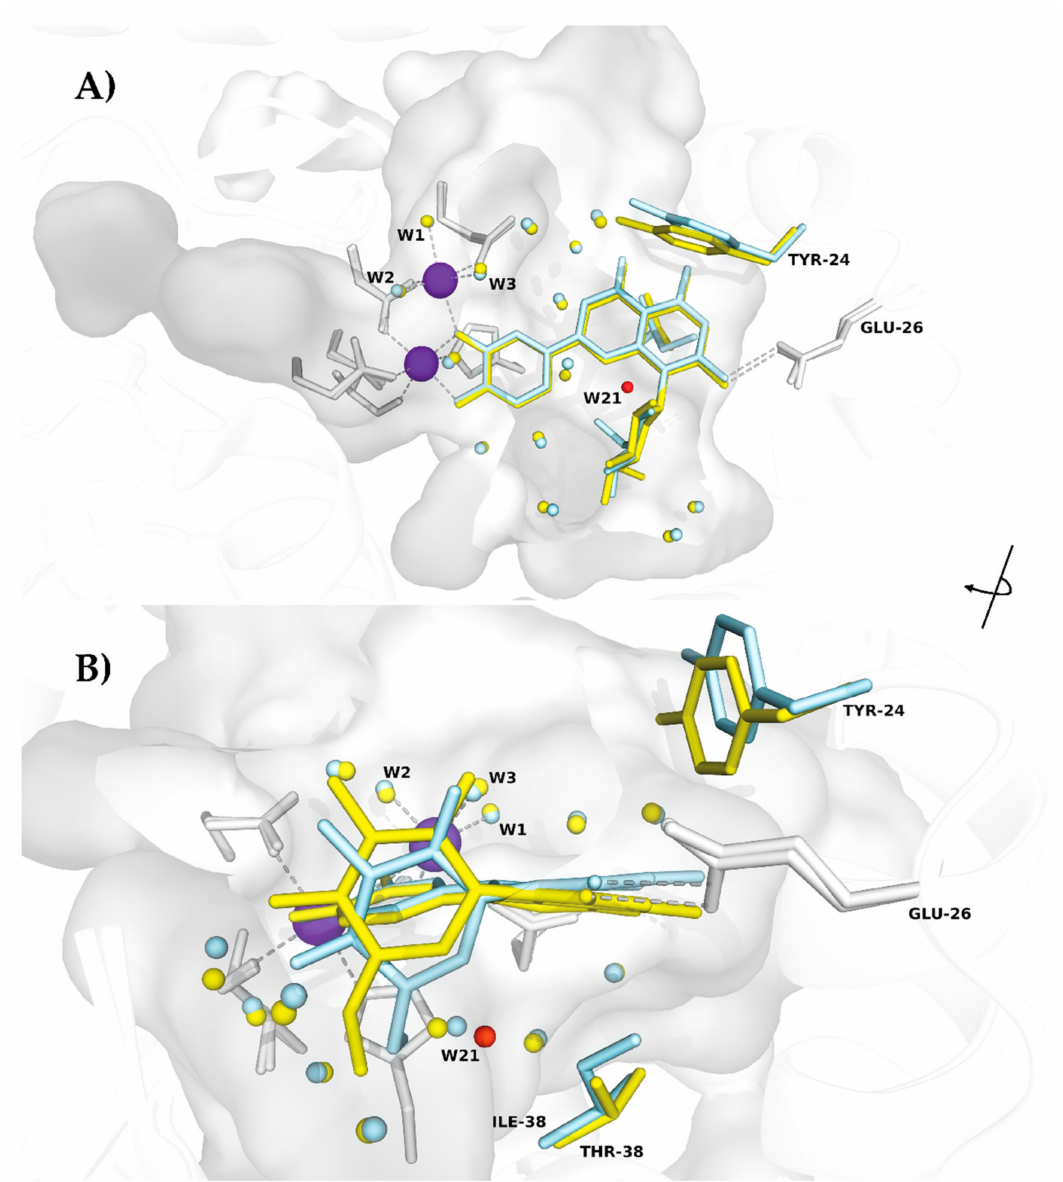
Figure 4. Structural alignment of wild-type PA-Nter (pale cyan) and its I38T mutant (yellow), both in complex with orientin (PDB ID 7NUG, 7NUH). The active site ( A ) containing two metal ions (purple-blue spheres) is presented as a surface cavity in grey. Closeup view, 90 ◦ clockwise rotated ( B ), onto interacting residues, Ile-38/Thr-38, and ligands (all in stick representation) reveals shift of the glucoside moiety. The hydrogen bond between ligand and the Glu-26 side chain is shown as a grey dash. Common waters contributing to protein-ligand binding, with a maximum distance of 3 Å from the ligand, are presented as spheres with color coding corresponding to each structure. Metal-coordinating water molecules (W1, W2 and W3) and W21 (red) are shown as